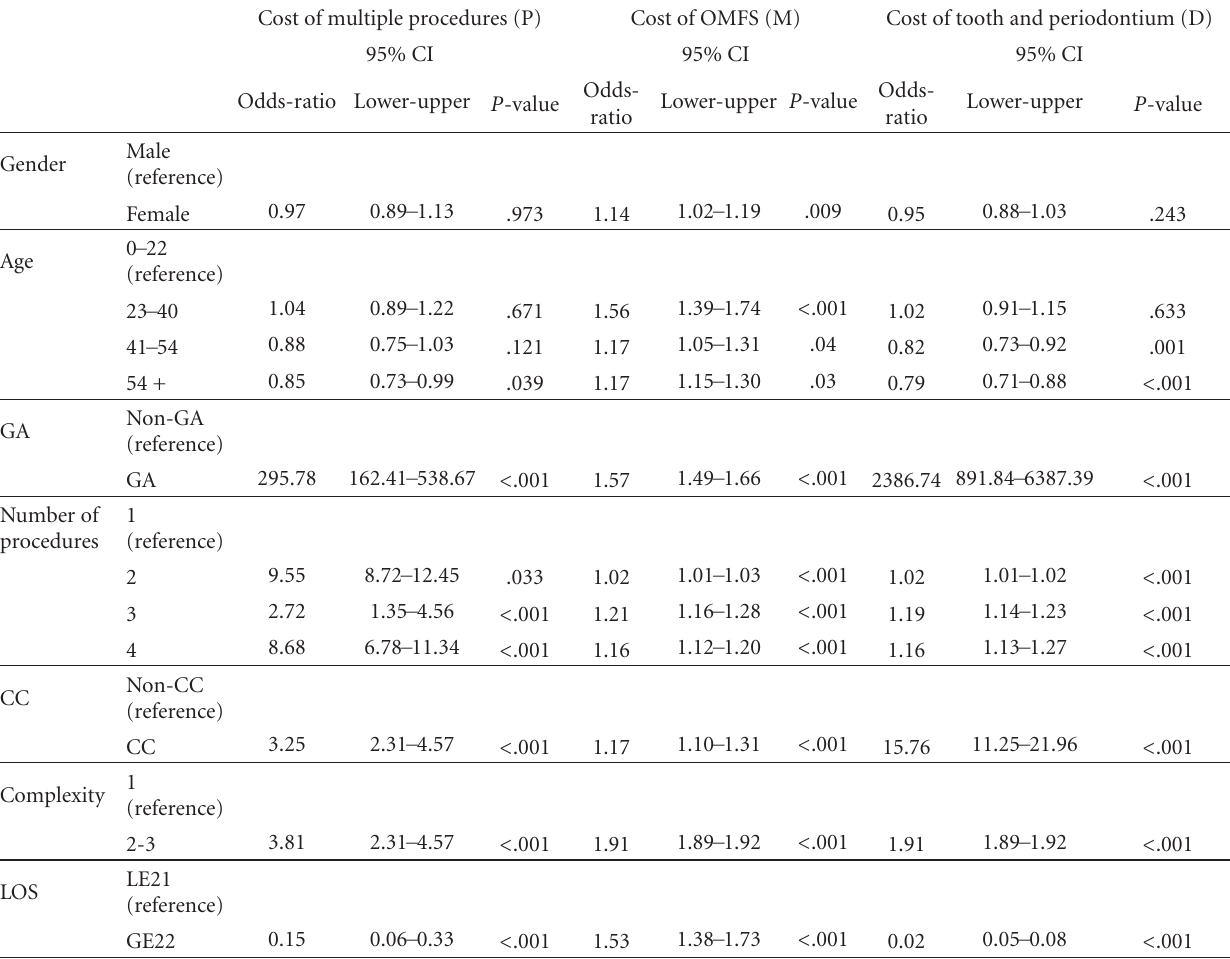
Table 3: Multiple regressions of the cost of multiple procedures (P), the cost of OMFS (M), and the cost of tooth and periodontium (D). Cost of multiple procedures (P)